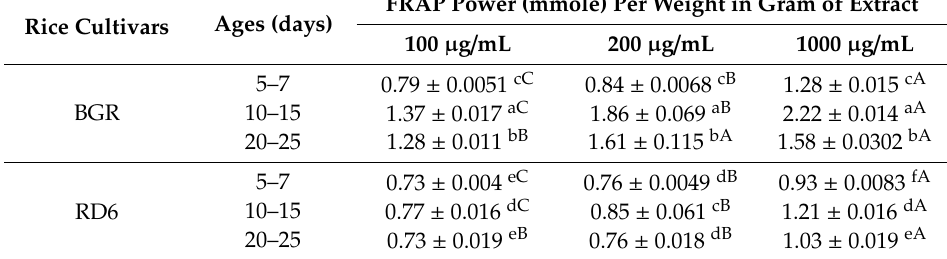
Table 3. Ferric reducing power of rice sprout extracts. Data are expressed as mean ± SD of absorbance ferric-to-ferrous reduction capacity of BGR and RD6 from five replicates ( p <